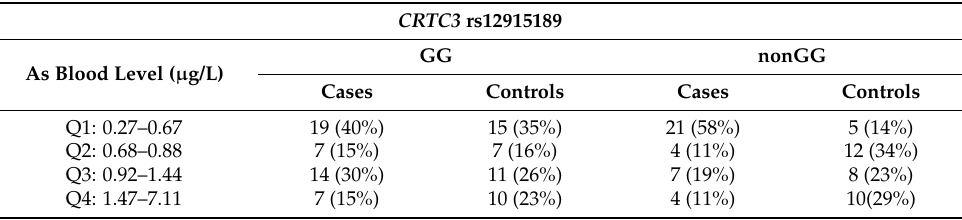
Table 6. Numbers of CRC cases and healthy controls depending on CRTC3 gene polymorphism and blood-As concentration in